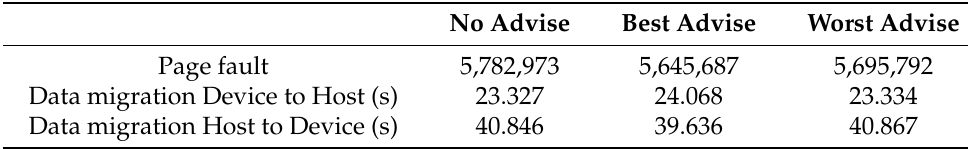
Table 3. Summary of profiling